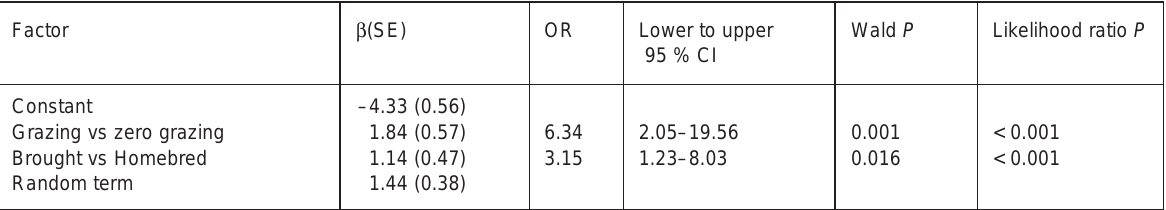
TABLE 3 Final logistic binomial multiple regression for sero-prevalence of Babesia bovis in dairy cattle, Tanga, Tanzania (January